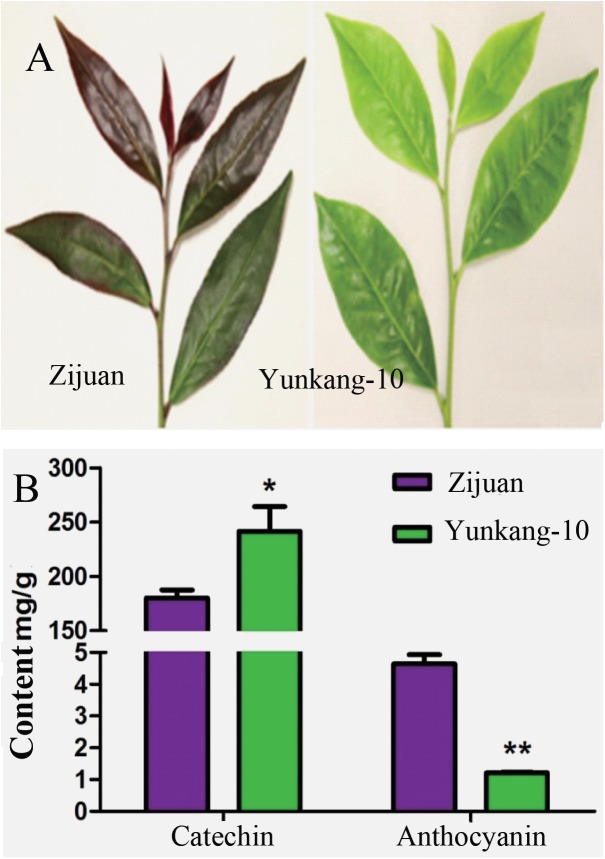
The contents of total catechins and anthocyanins in fresh leaf of Zijuan and Yunkang-10 (∗p < 0.05, ∗∗p < 0.01). (A) The leaf photographs of Zijuan and Yunkang-10. (B) The total contents of catechins and anthocyanins.